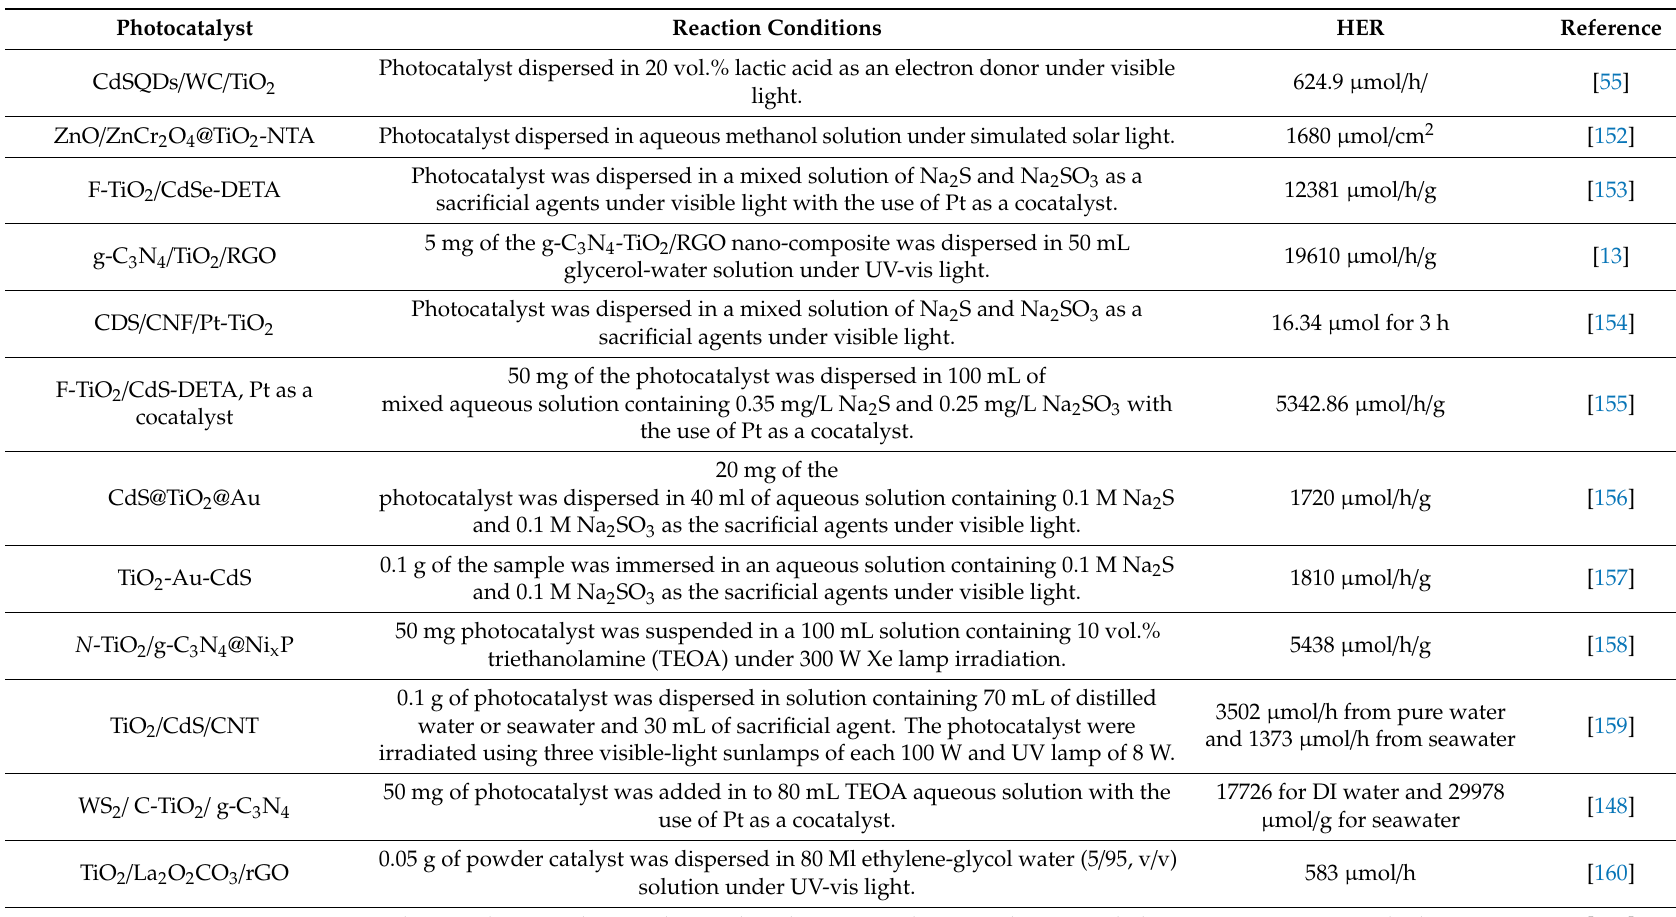
Table 11. Multiple TiO 2 -based composites for the use in photocatalytic hydrogen generation. Photocatalyst Reaction Conditions HER Reference CdSQDs / WC / TiO